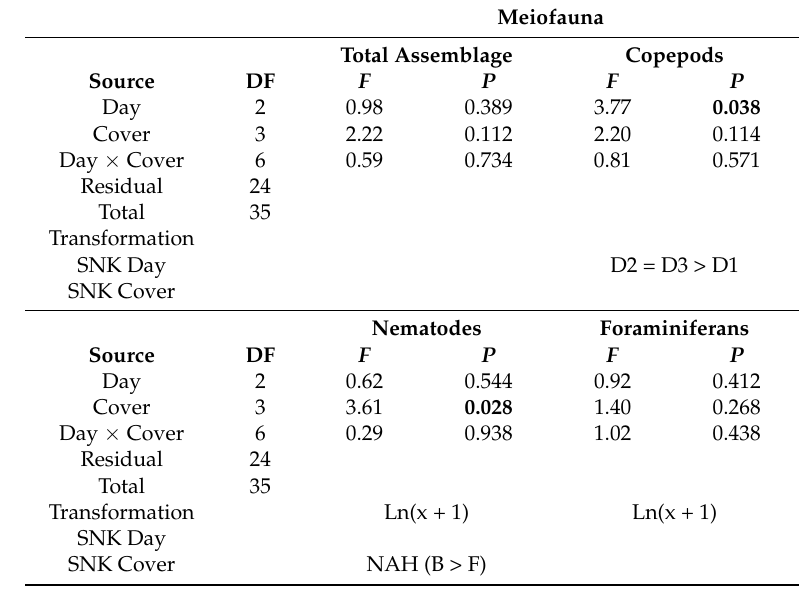
Table 5. ANOVA results for meiofauna in traps: bulk dispersal rates (BDRs). Transformations indicated where applied. Significant differences ( P < 0.05) are in bold. For parameters with significant differences, the SNK results are presented. NAH = no alternative hypothesis; the two groups with the largest and smallest means within the factor were significantly different, and no further resolution among the groups in that factor could be determined. F = fragmented shells, B = bare sediment. D1 = Day 1, D2 = Day 2, D3 = Day 3.